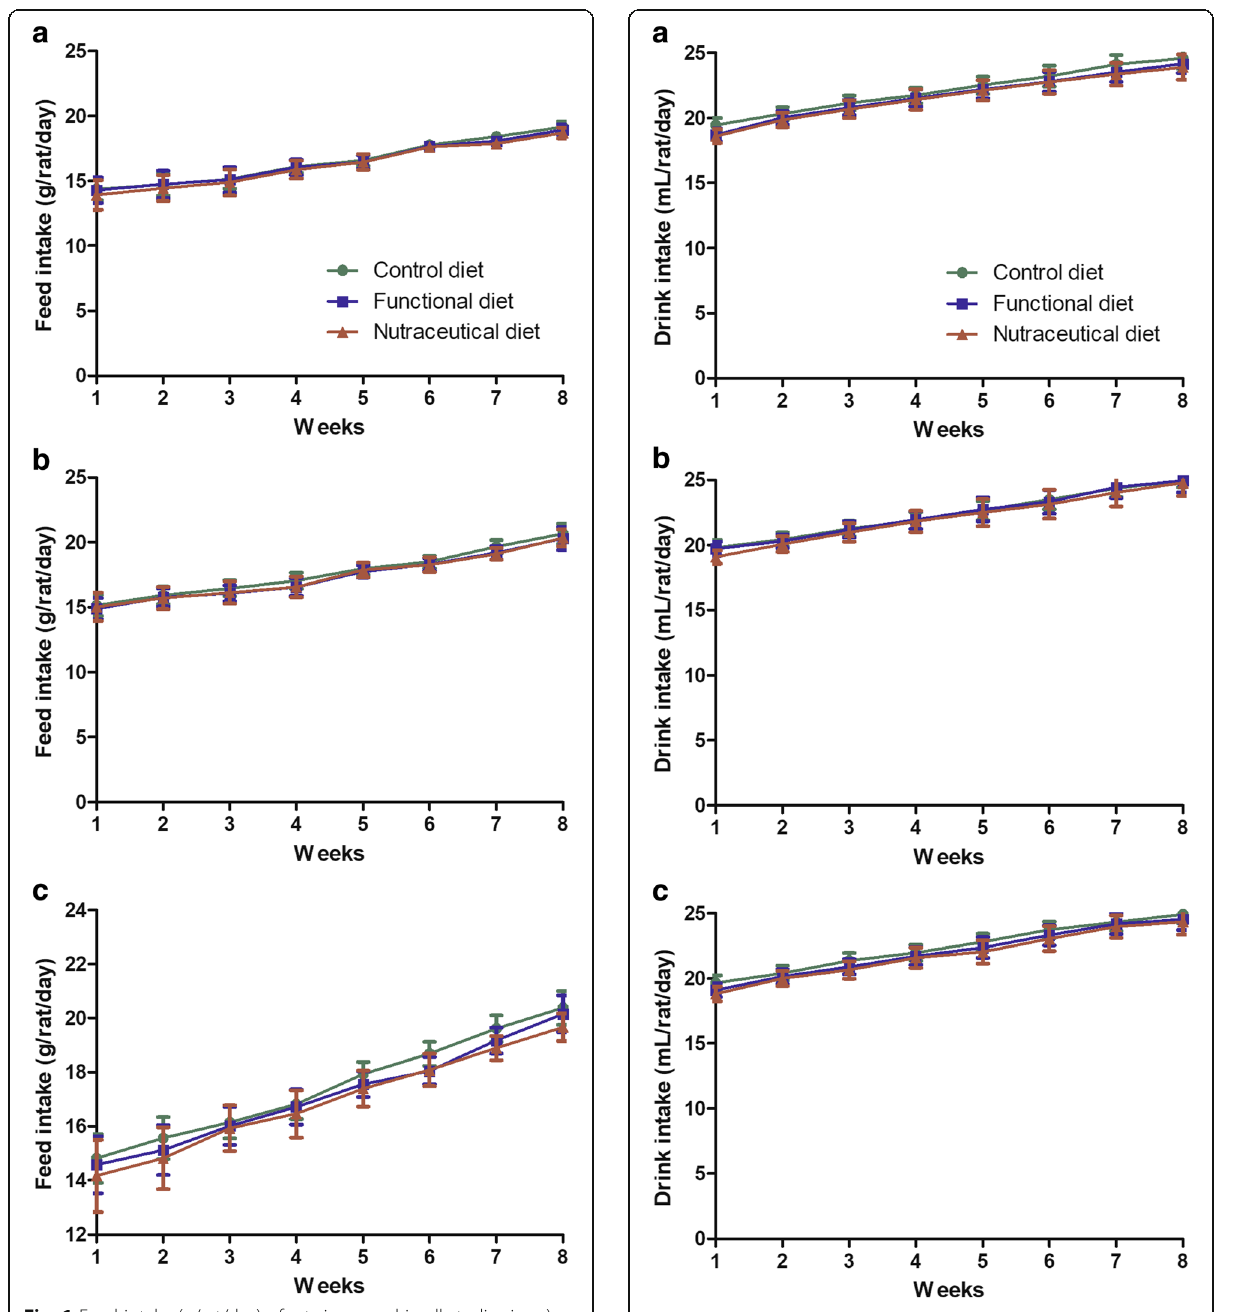
Fig. 1 Feed intake (g/rat/day) of rats increased in all studies i.e. a ) Normal rats, b ) hyperglycemic rats, c ) hypercholestrolemic rats, from 1st to 8th week. Three type of diets were provided in each study; control diet, Functional diet (prepared by conventional solvent